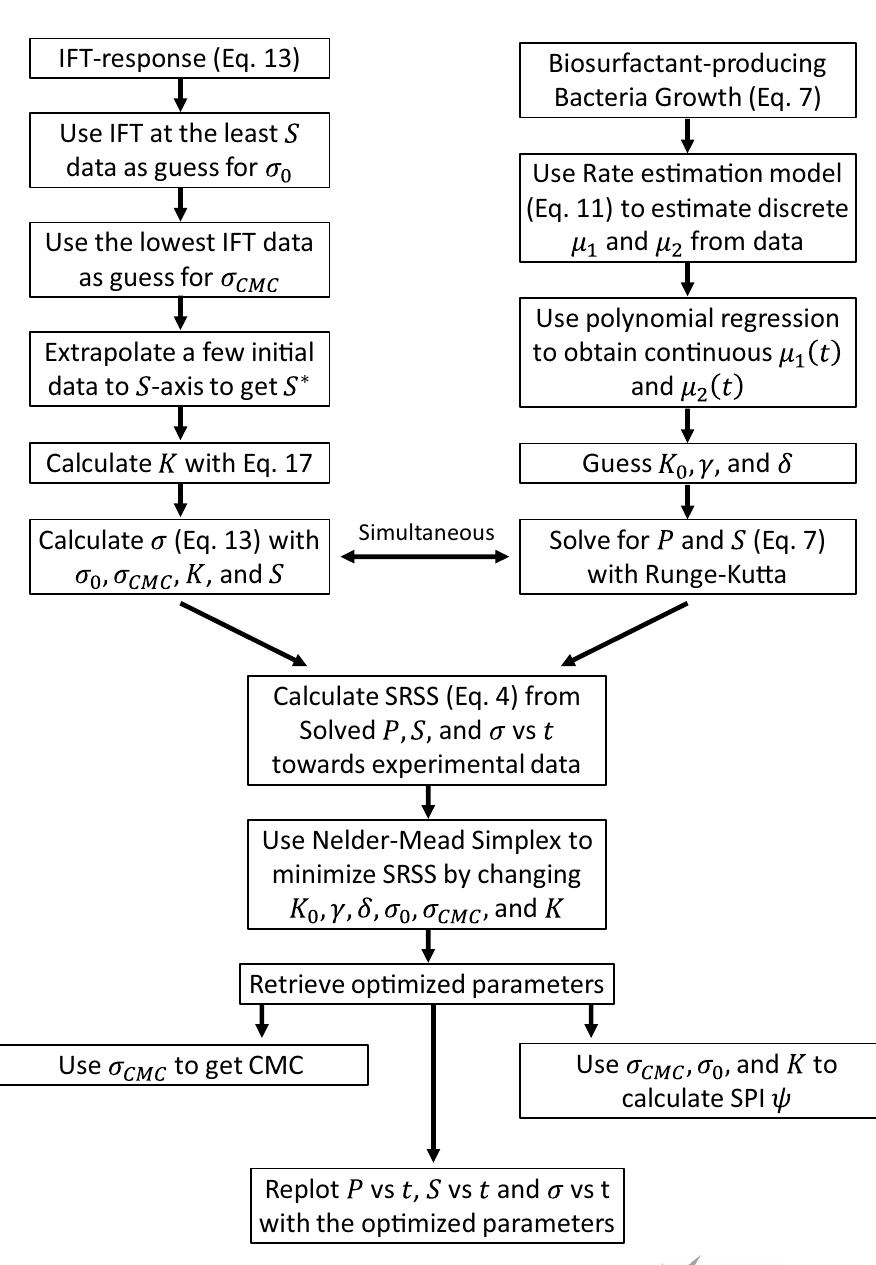
Fig. 1 Workflow of the inte- grated